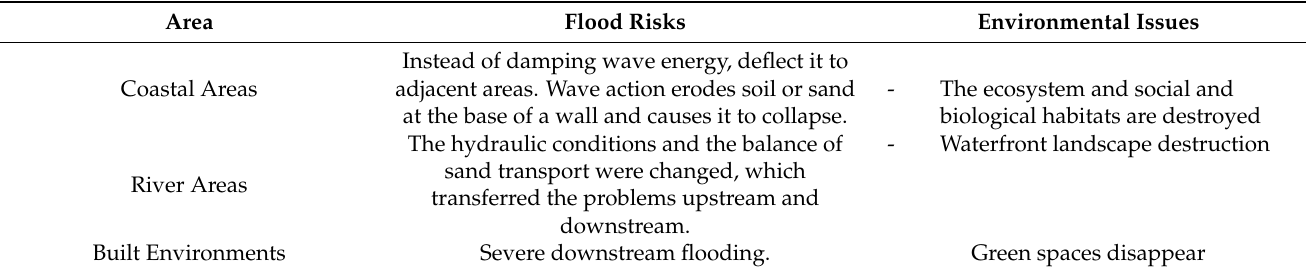
Table 2. Summary of disadvantages of traditional methods for different flood